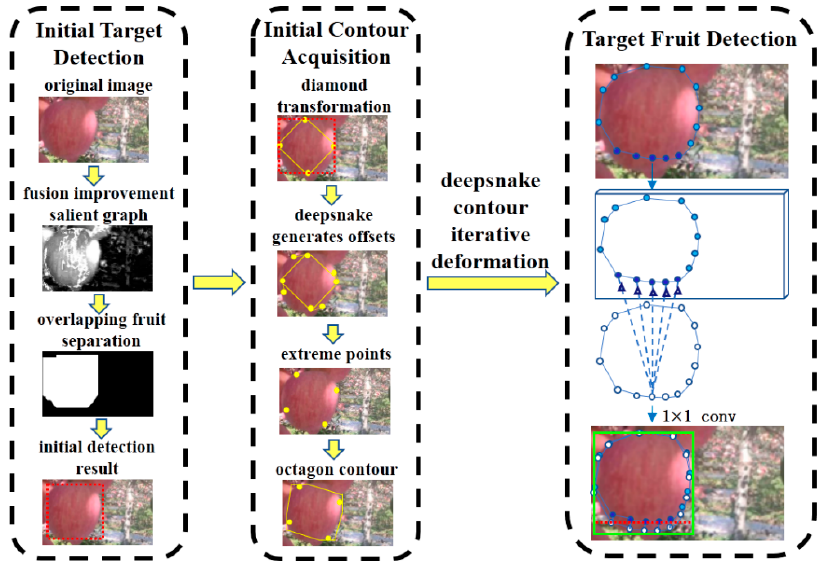
Figure 1. The overall flow chart of the proposed method (in the diagram of the DeepSnake pro- cessing process, solid round points are input features, triangular points are convolution kernel, and hollow round points are output. The dotted line detection box is the initial detection box, and the solid line detection box is the final detection result obtained after the segmentation of DeepSnake instances).